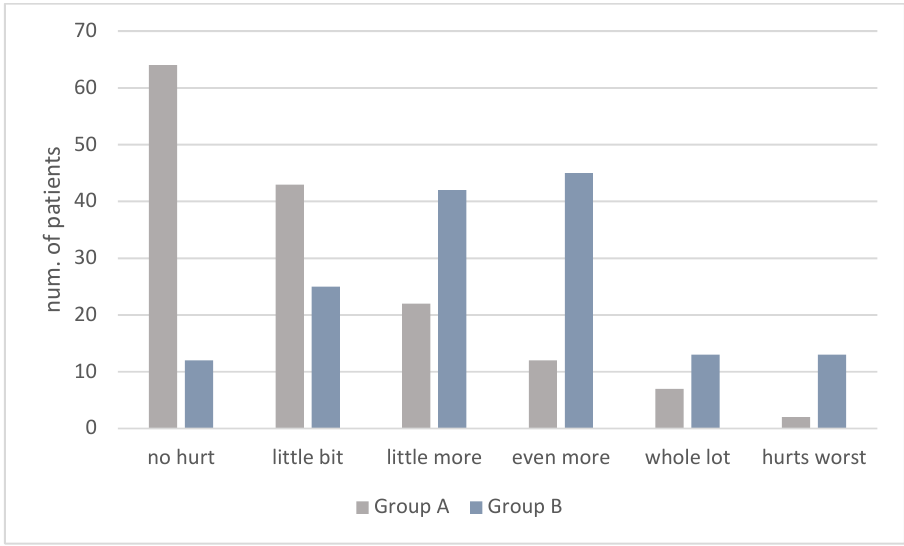
Figure 1. PRS scores in Group A and B.